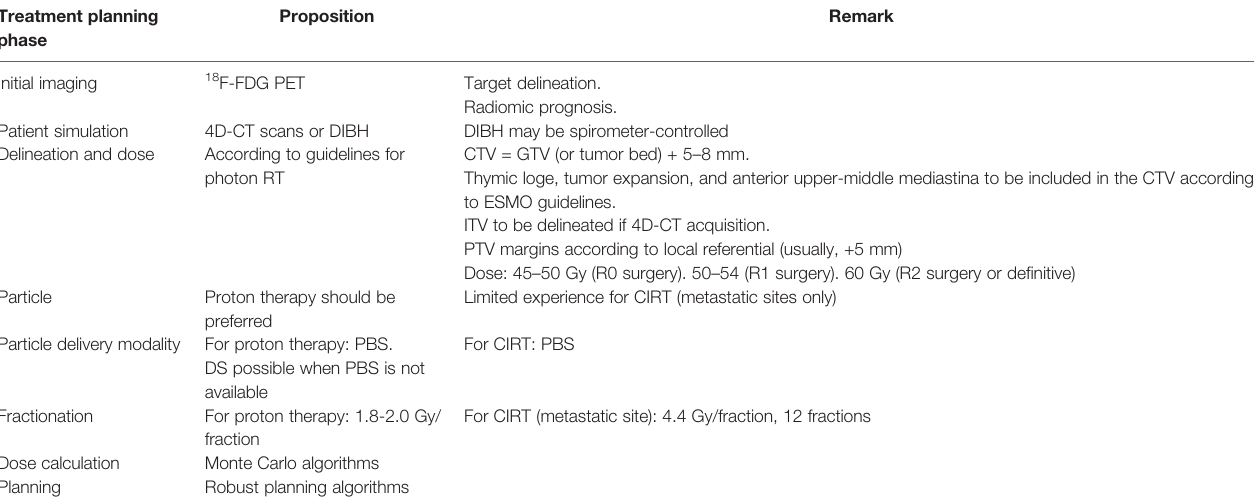
TABLE 2 | Practical propositions for hadron therapy for thymic epithelial tumor irradiation.